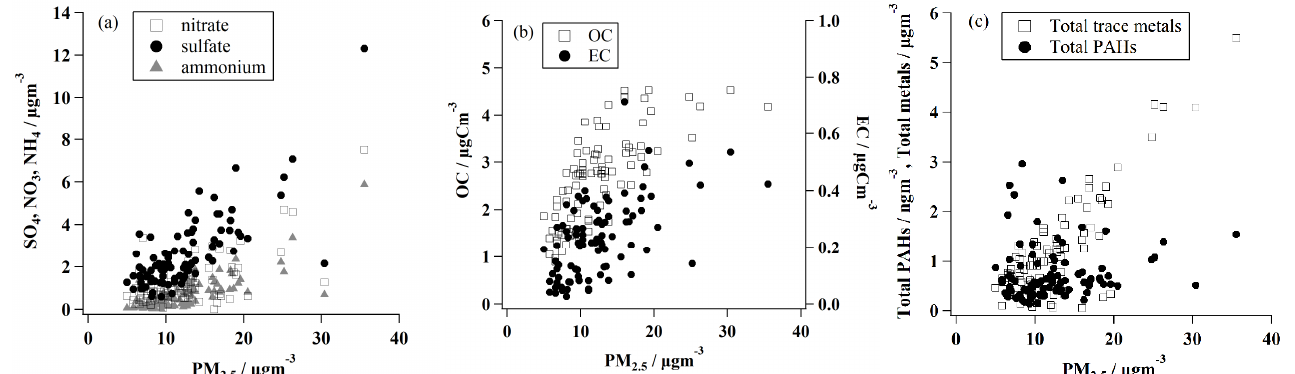
Figure 4. Correlation plots of various chemical components with respect to PM 2 . 5 . ( a ) Sulfate, nitrate, and ammonium. ( b ) OC and EC. ( c ) Total trace metals and total PAHs.